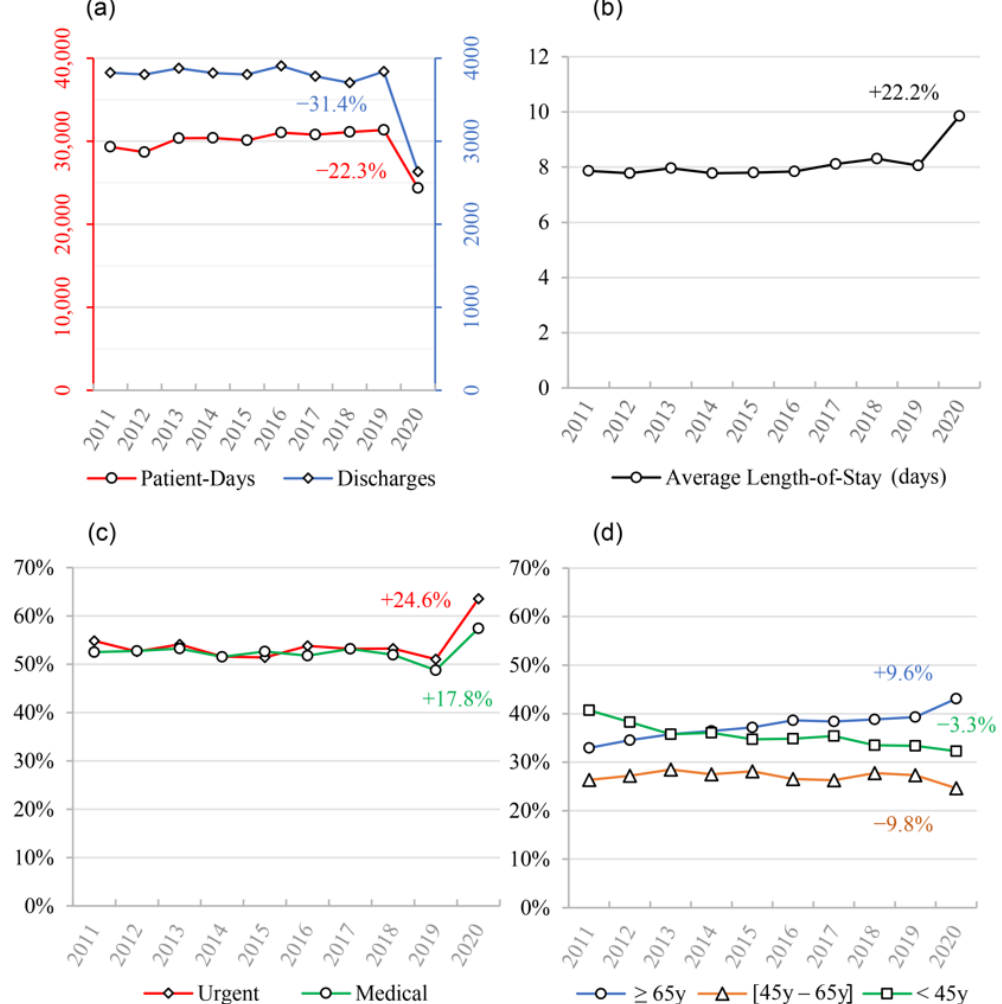
Figure 1. Summary of CHUSJ’s population characteristics observed between 2011 and 2020. ( a ) March–May average discharges and patient-days; ( b ) March–May average length-of-stay; ( c ) March–May average proportion of urgent and medical admissions; ( d ) March–May average proportions of age groups admitted to CHUSJ. Annual percentage changes (APCs) are shown within the graphs.